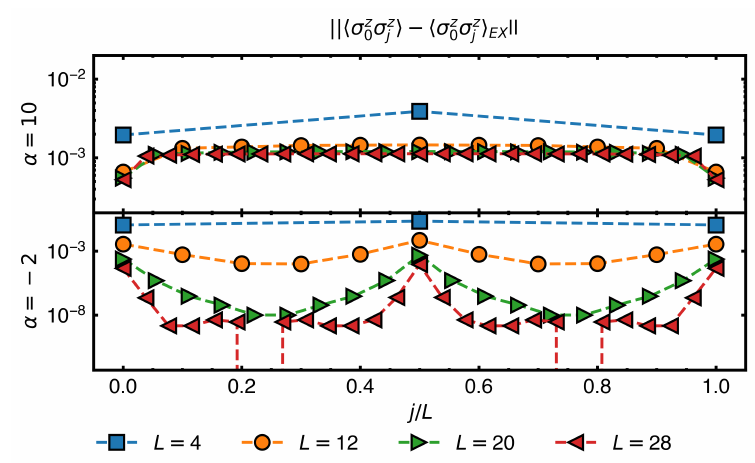
Figure 14: Difference between numerical correlation functions computed on the JG states and the analytic formulae Eq. (49). The different system sizes show a scaling to zero, confirming the correctness of the GHZ